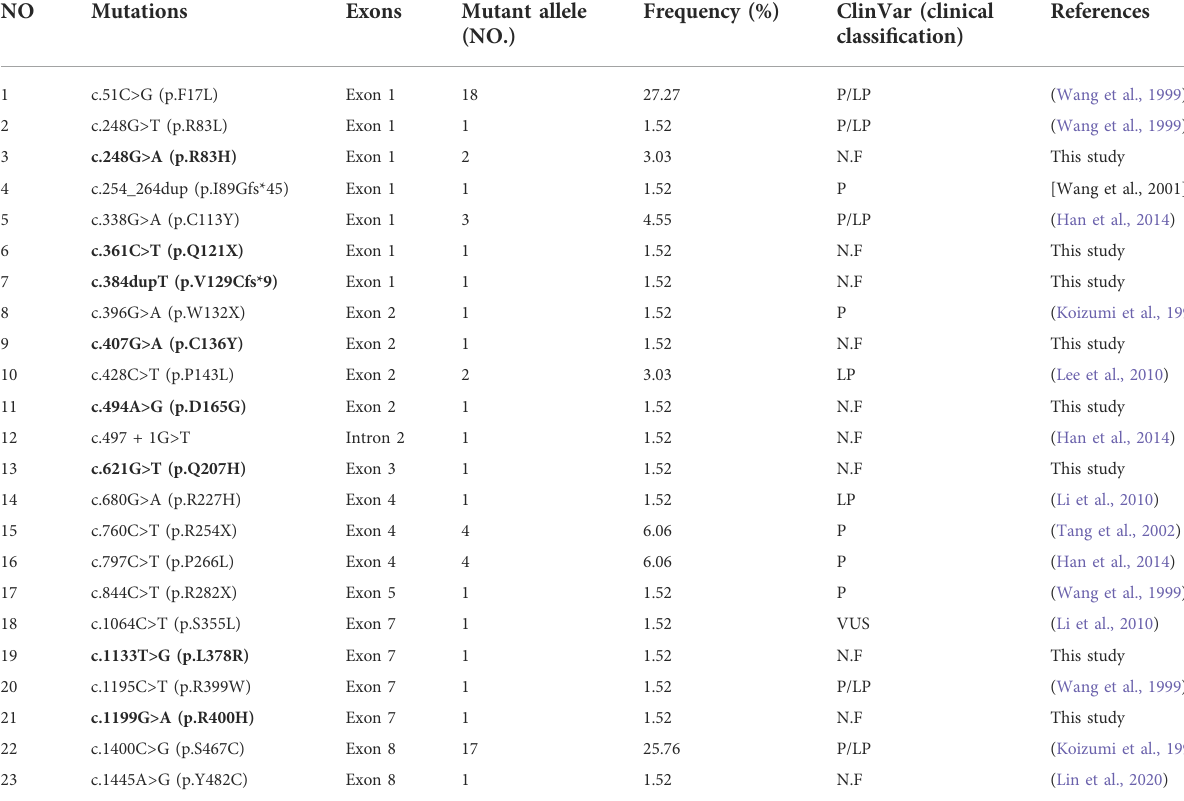
TABLE 2 Frequencies, locations, and clinical classi fi cation of detected mutations.